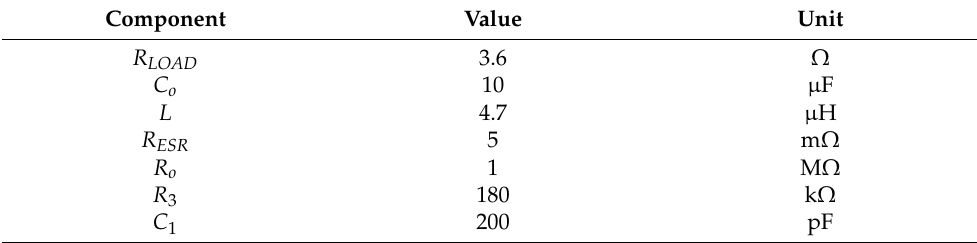
Table 1. Design parameters.